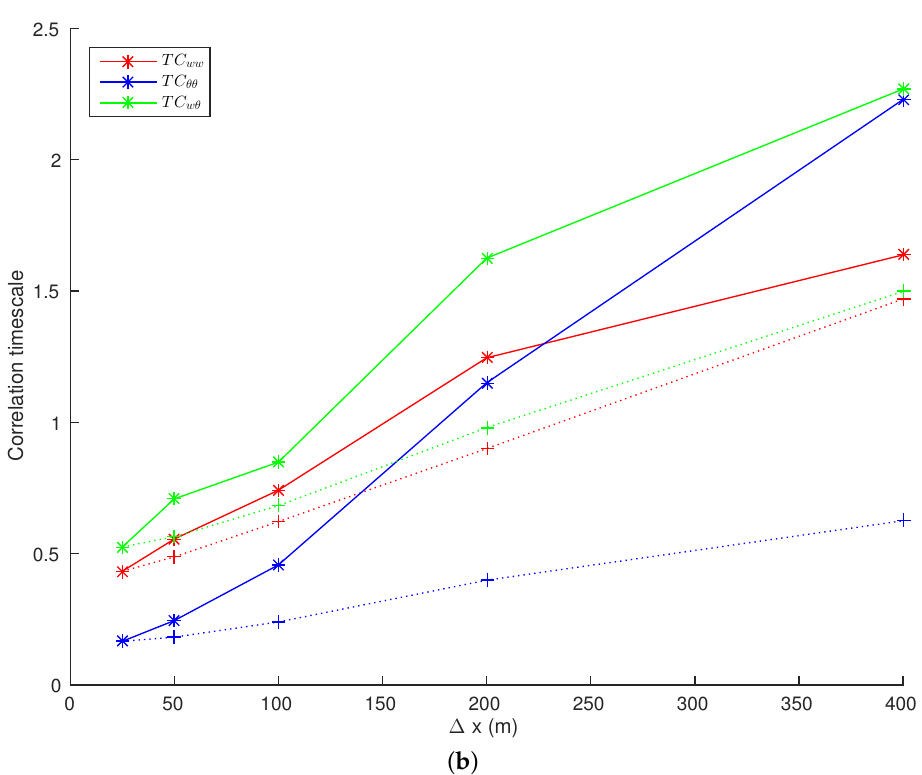
Figure 14. The correlation ( a ) length scales and ( b ) time scales for correlation functions evaluated at 500 m. The scales for ψ = χ = w are shown in red, for ψ = χ = θ in blue and for ψ = w , χ = θ in green. Scales obtained from the CBL2 simulations with different grid lengths are plotted with solid lines and asterisks against the grid length. Scales obtained after coarse graining the results of the 25 m simulation are plotted with plus symbols and dotted